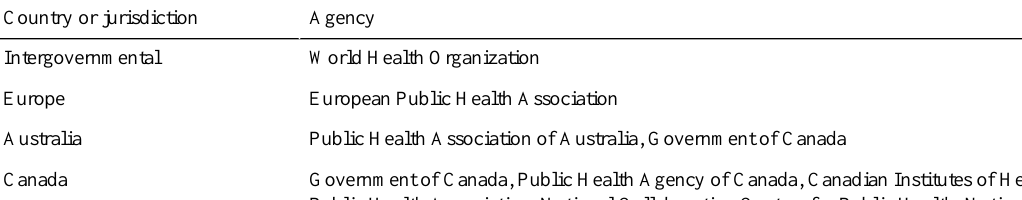
Table 2. Agency and country websites searched for grey